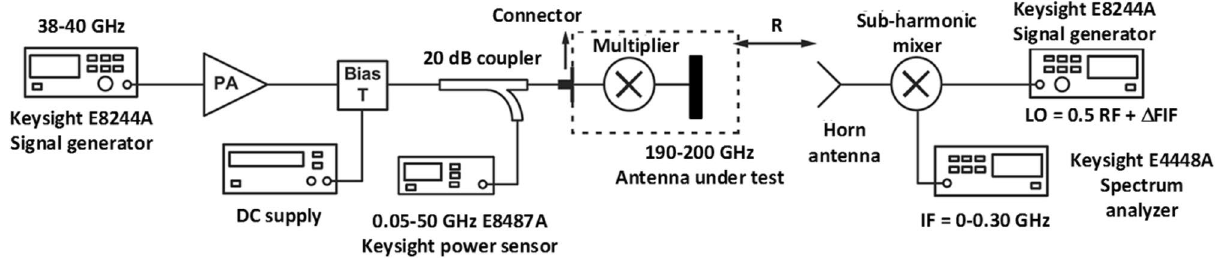
Figure 16. Set-up to measure the array’s radiation patterns.